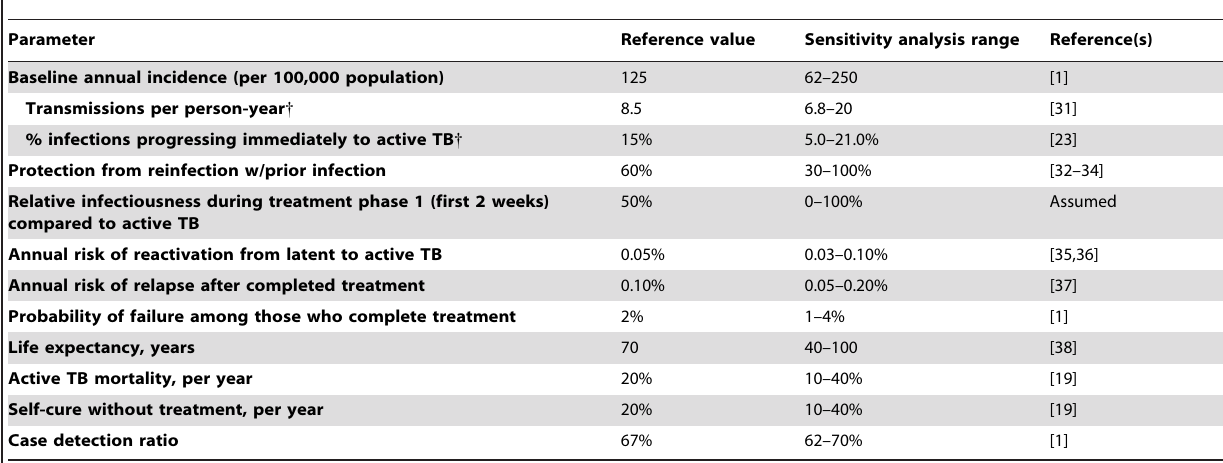
Table 2. Selected key input parameters for estimating transmission impact of shorter TB